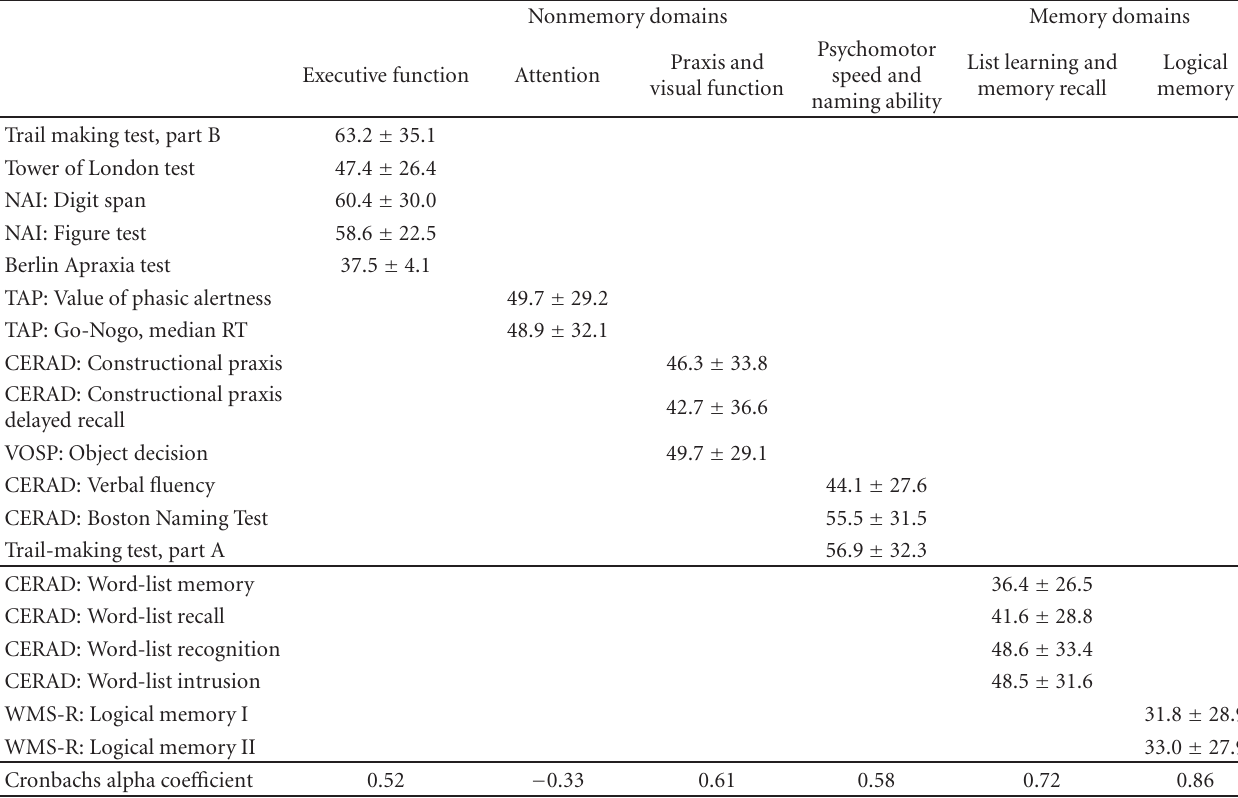
Table 1: Overview of the cognitive